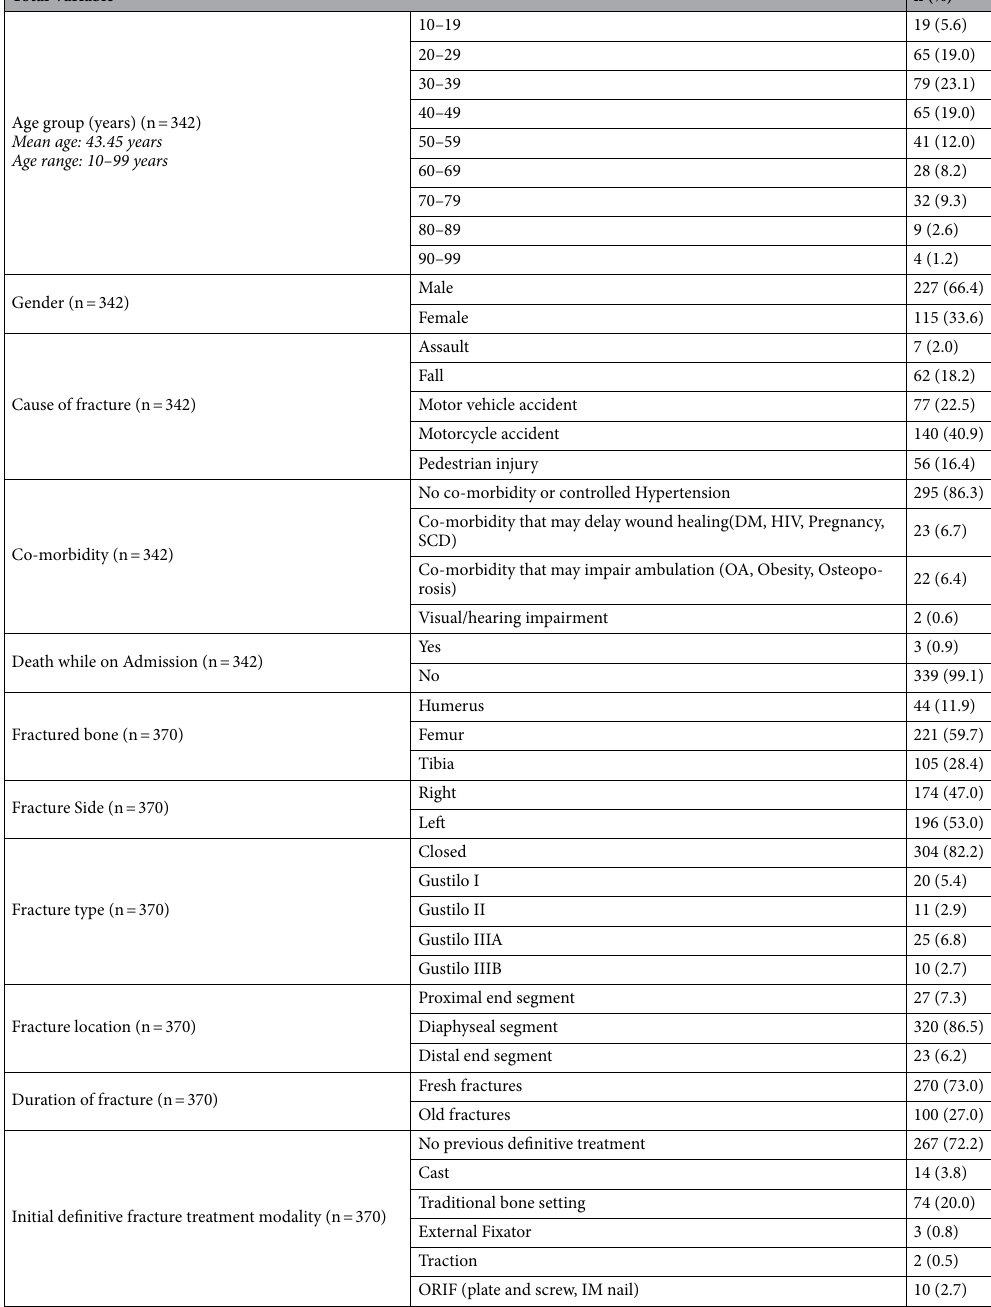
Table 1. Patients’ and fracture characteristics. DM diabetes mellitus, HIV human immunodeficiency virus infection, SCD Sickle cell disease, OA Osteoarthritis, ORIF open reduction and internal